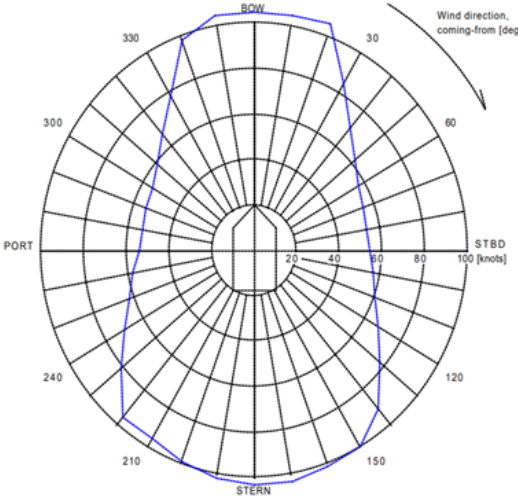
Figure 1. Sample chart with the capability plot (CP) analysis.